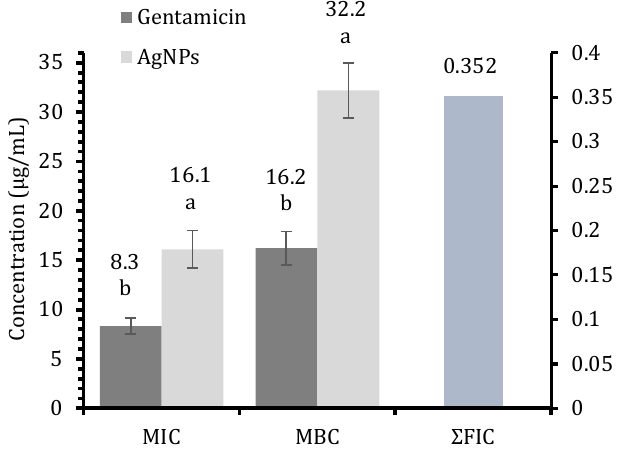
Figure 2 . MIC, MBC and ΣFIC index for gentamicin and AgNPs